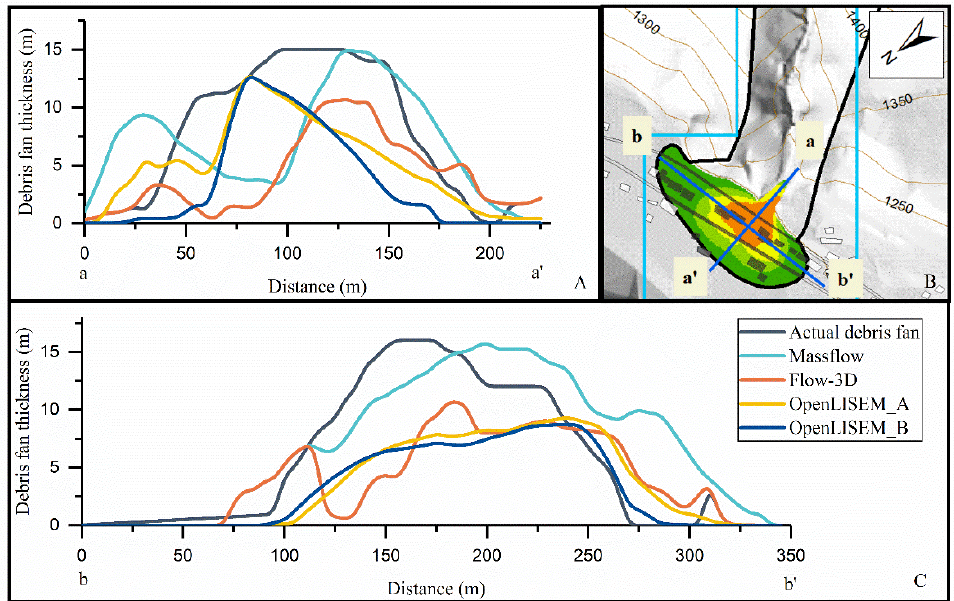
Figure 9. Comparison of debris fan thickness in 2013 (along two representative cross-sections). Including the actual debris fan and the debris fan of best-fit simulations by Massflow, Flow-3D, OpenLISEM_A, and OpenLISEM_B. ( A ) shows the debris fan thickness along the cross-section a-a’, and ( C ) shows the debris fan thickness along the cross-section b-b’. The locations of a-a’ and b-b’ are shown in ( B ).